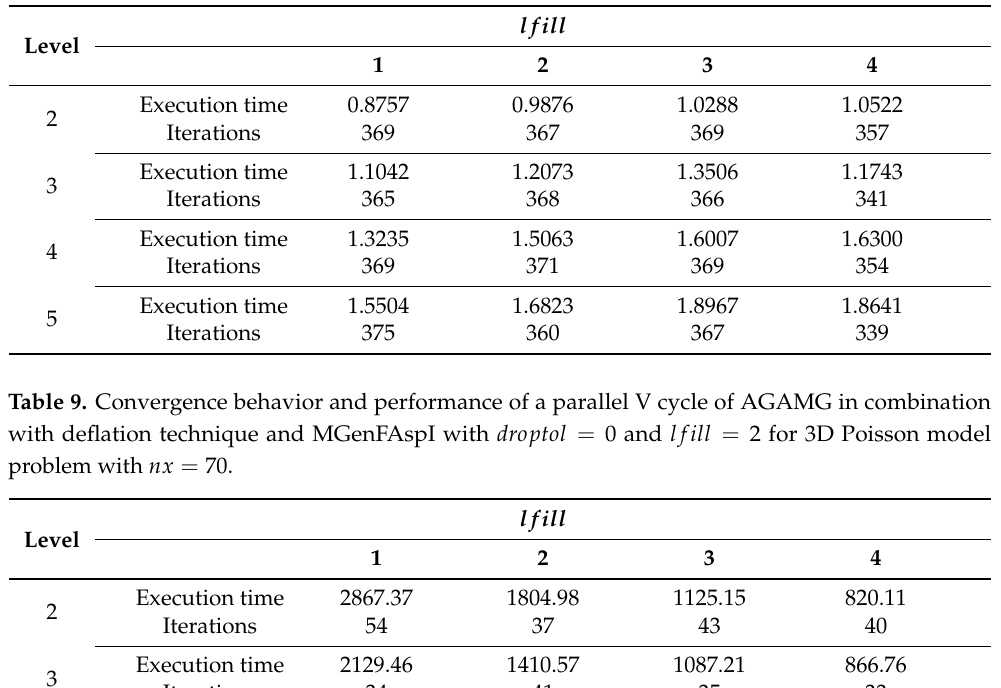
Table 8. Convergence behavior and performance of V cycle of AGAMG in combination with deflation technique and MGenFAspI with droptol = 0 and different values of l fill for Sherman1 problem.